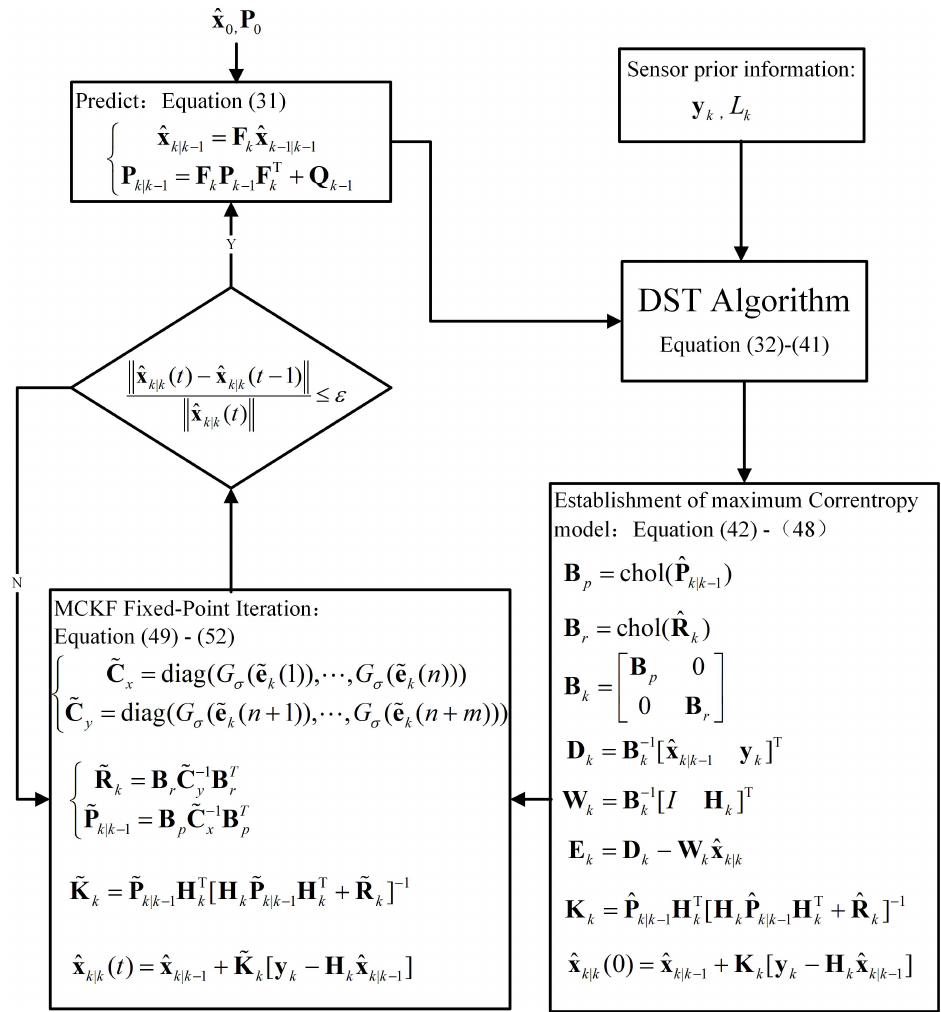
Figure 4. Flowchart of DSTMCKF